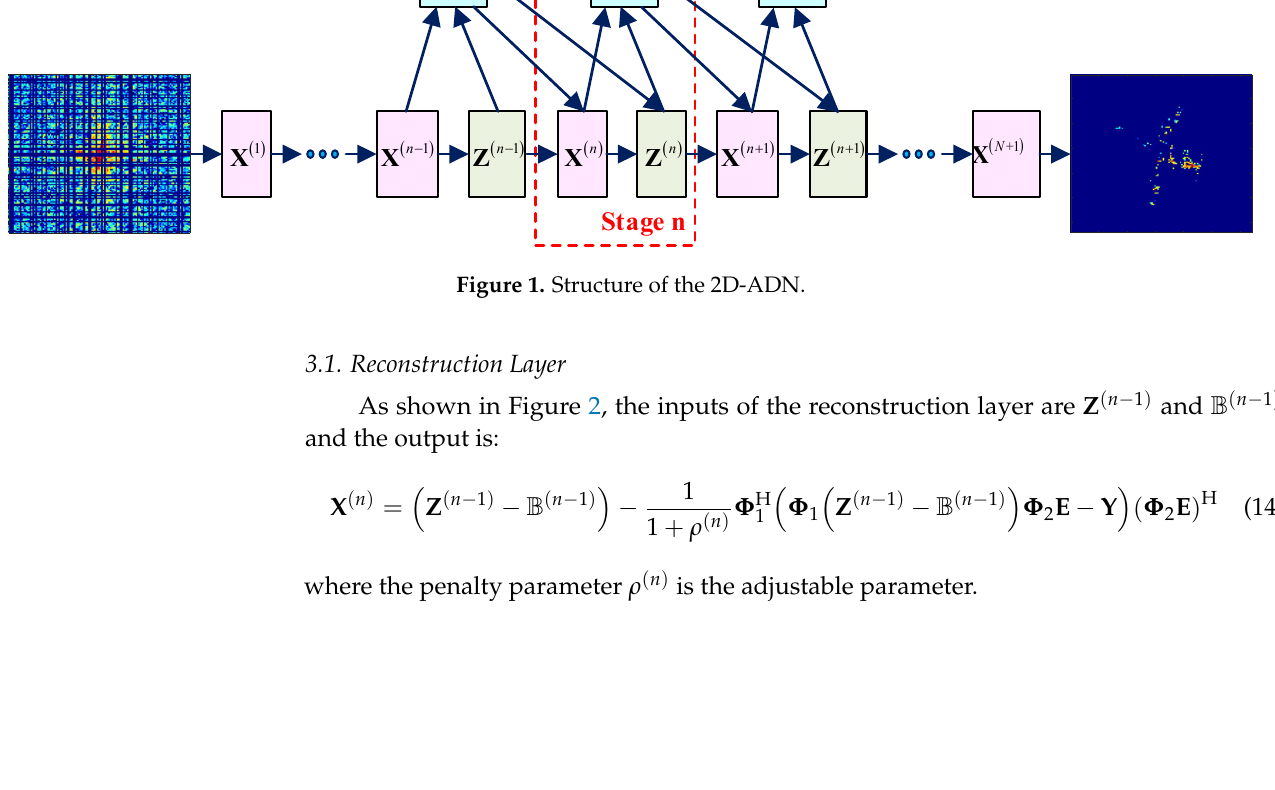
Figure 2. Reconstruction layer. For